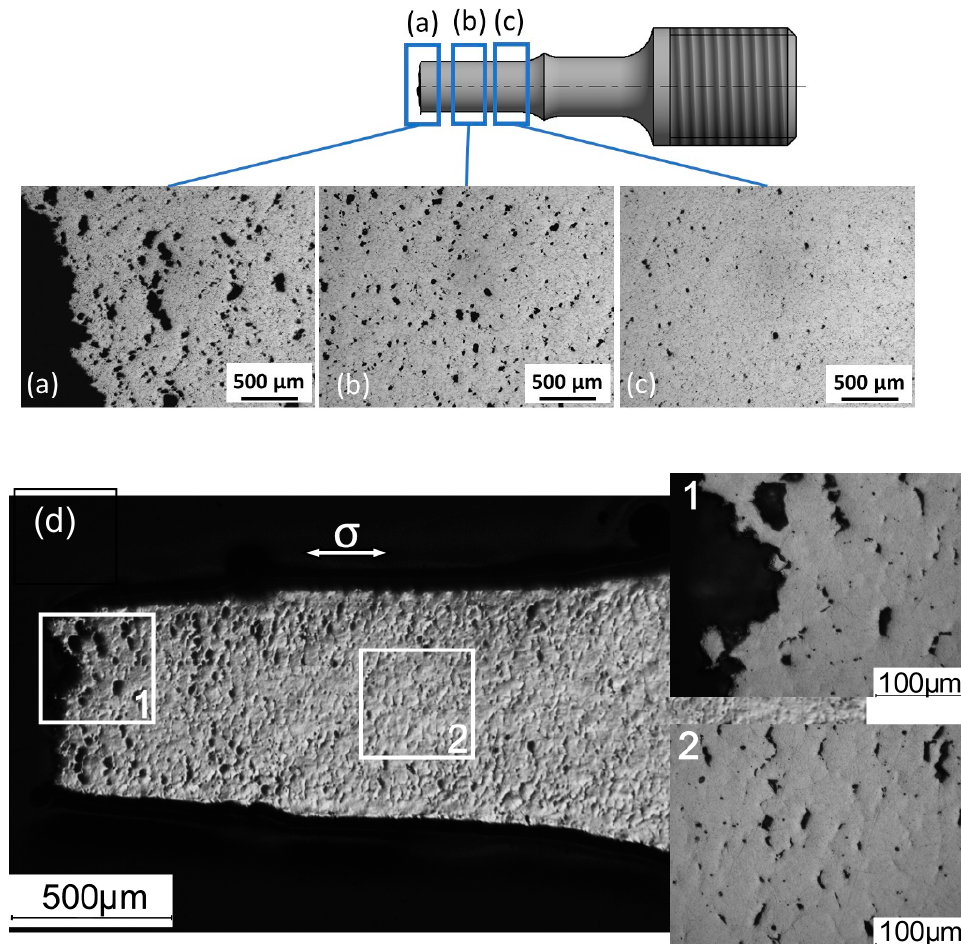
Figure 8. Creep damage, 20 MPa, longitudinal section; (a–c) standard specimen, ( a ) near fracture surface, ( b ) 5 mm distance to fracture surface, ( c ) 10 mm distance to fracture surface; ( d ) miniature specimen.